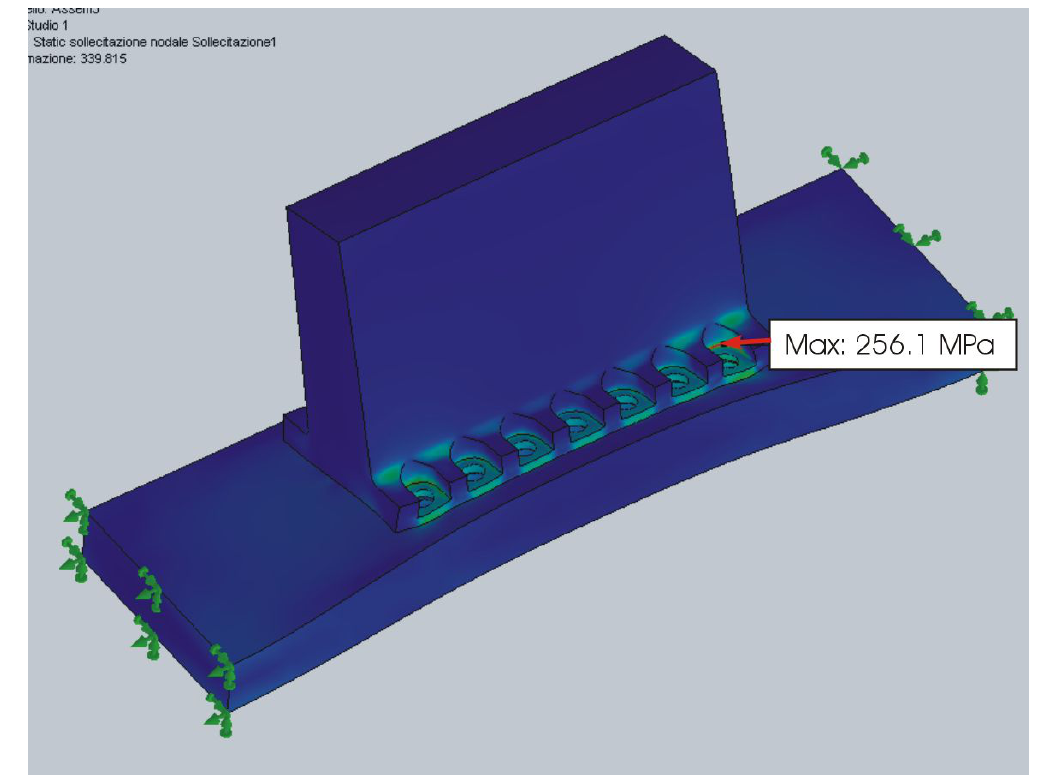
Figure 12: Maximum stresses and deformations evaluated by FEM analysis of the base - pole piece set joined by screws.